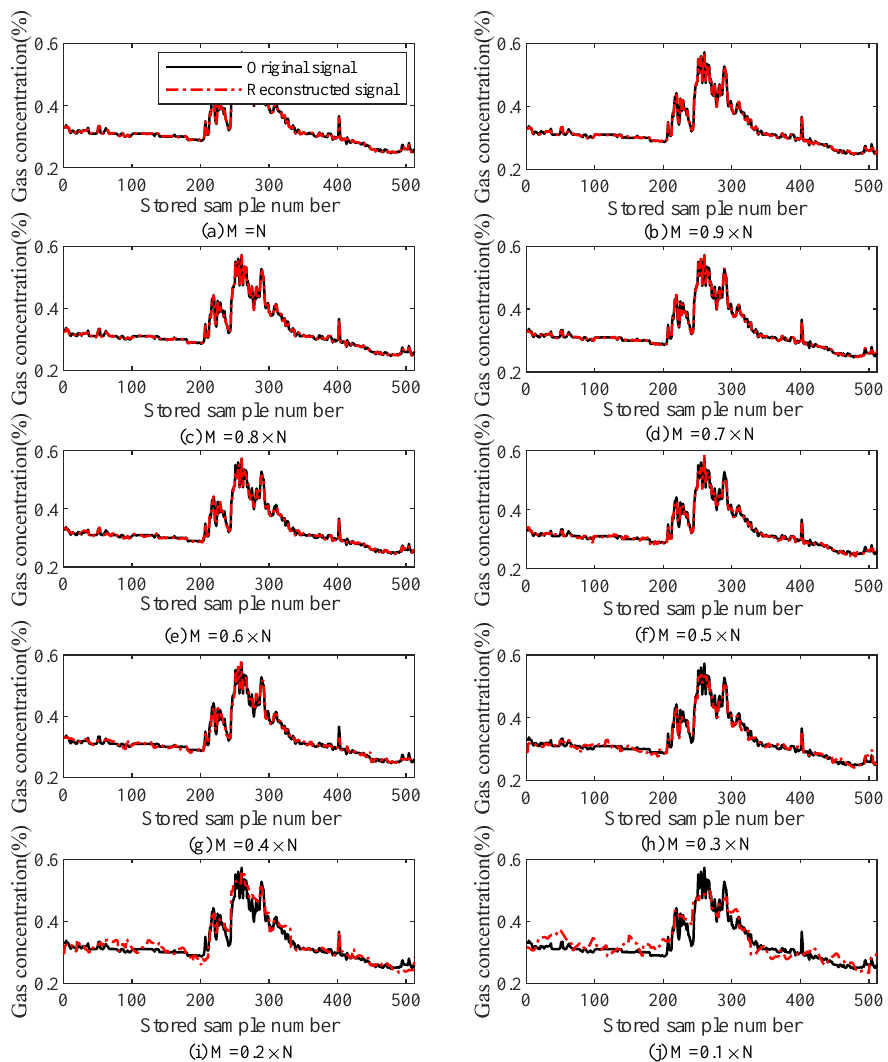
Figure 6. Compression perception and the reconstruction error of gas mutation data (TVS ‐ MH).